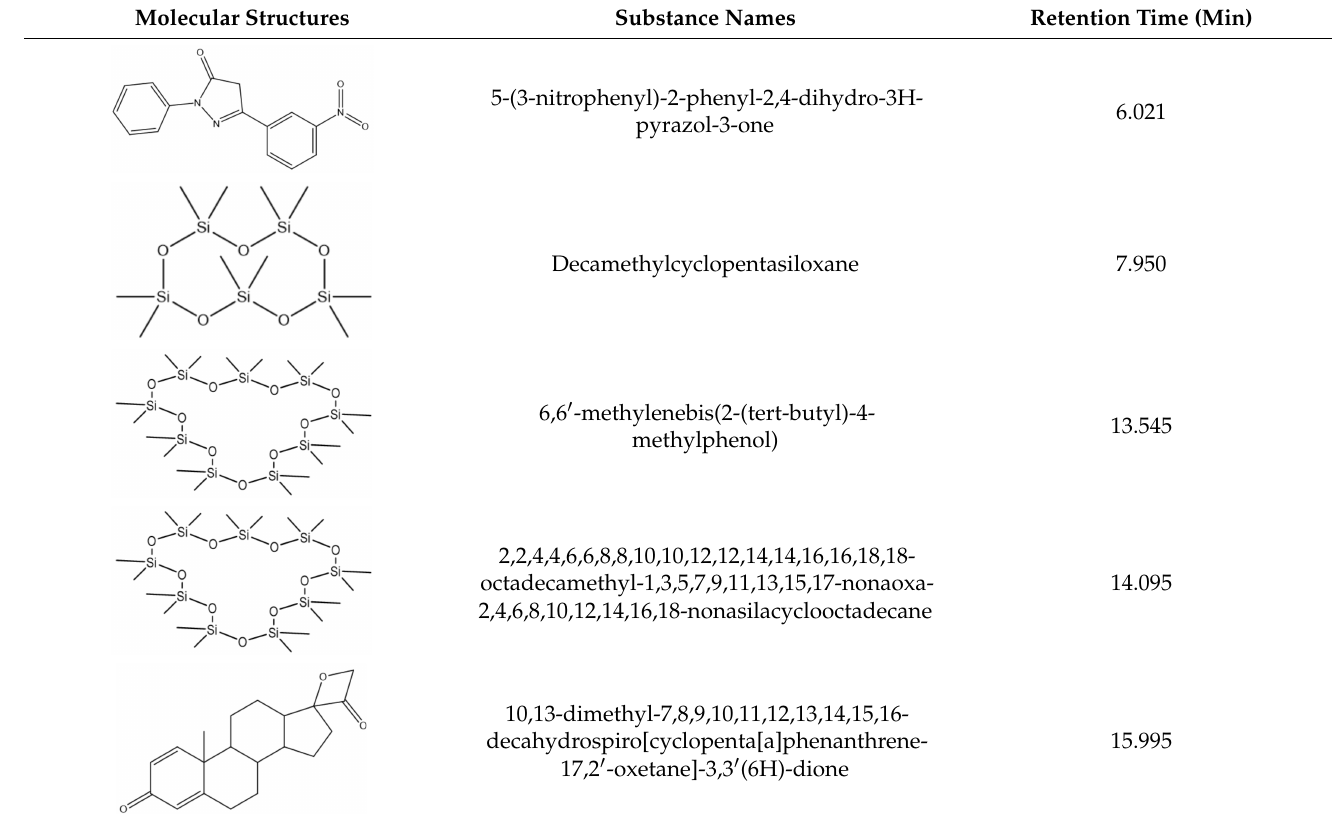
Table 2. Five organic compounds verified in the raw wastewater detected by